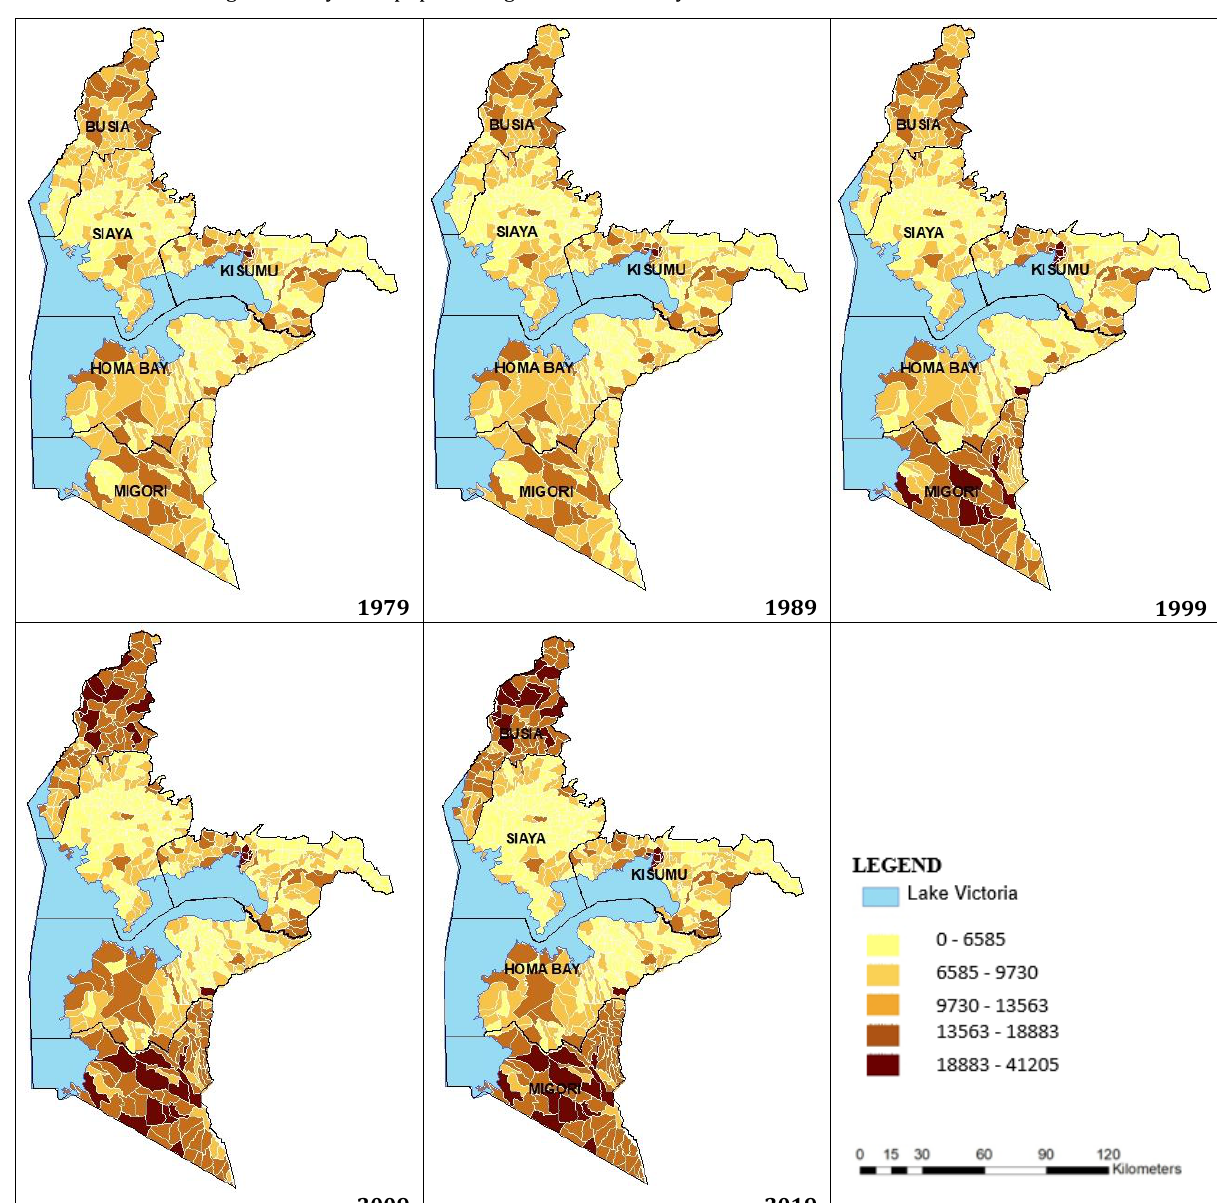
Fig. 6. The distribution of the population in the Lake Victoria Basin in 1979, 1989, 1999, 2009 and